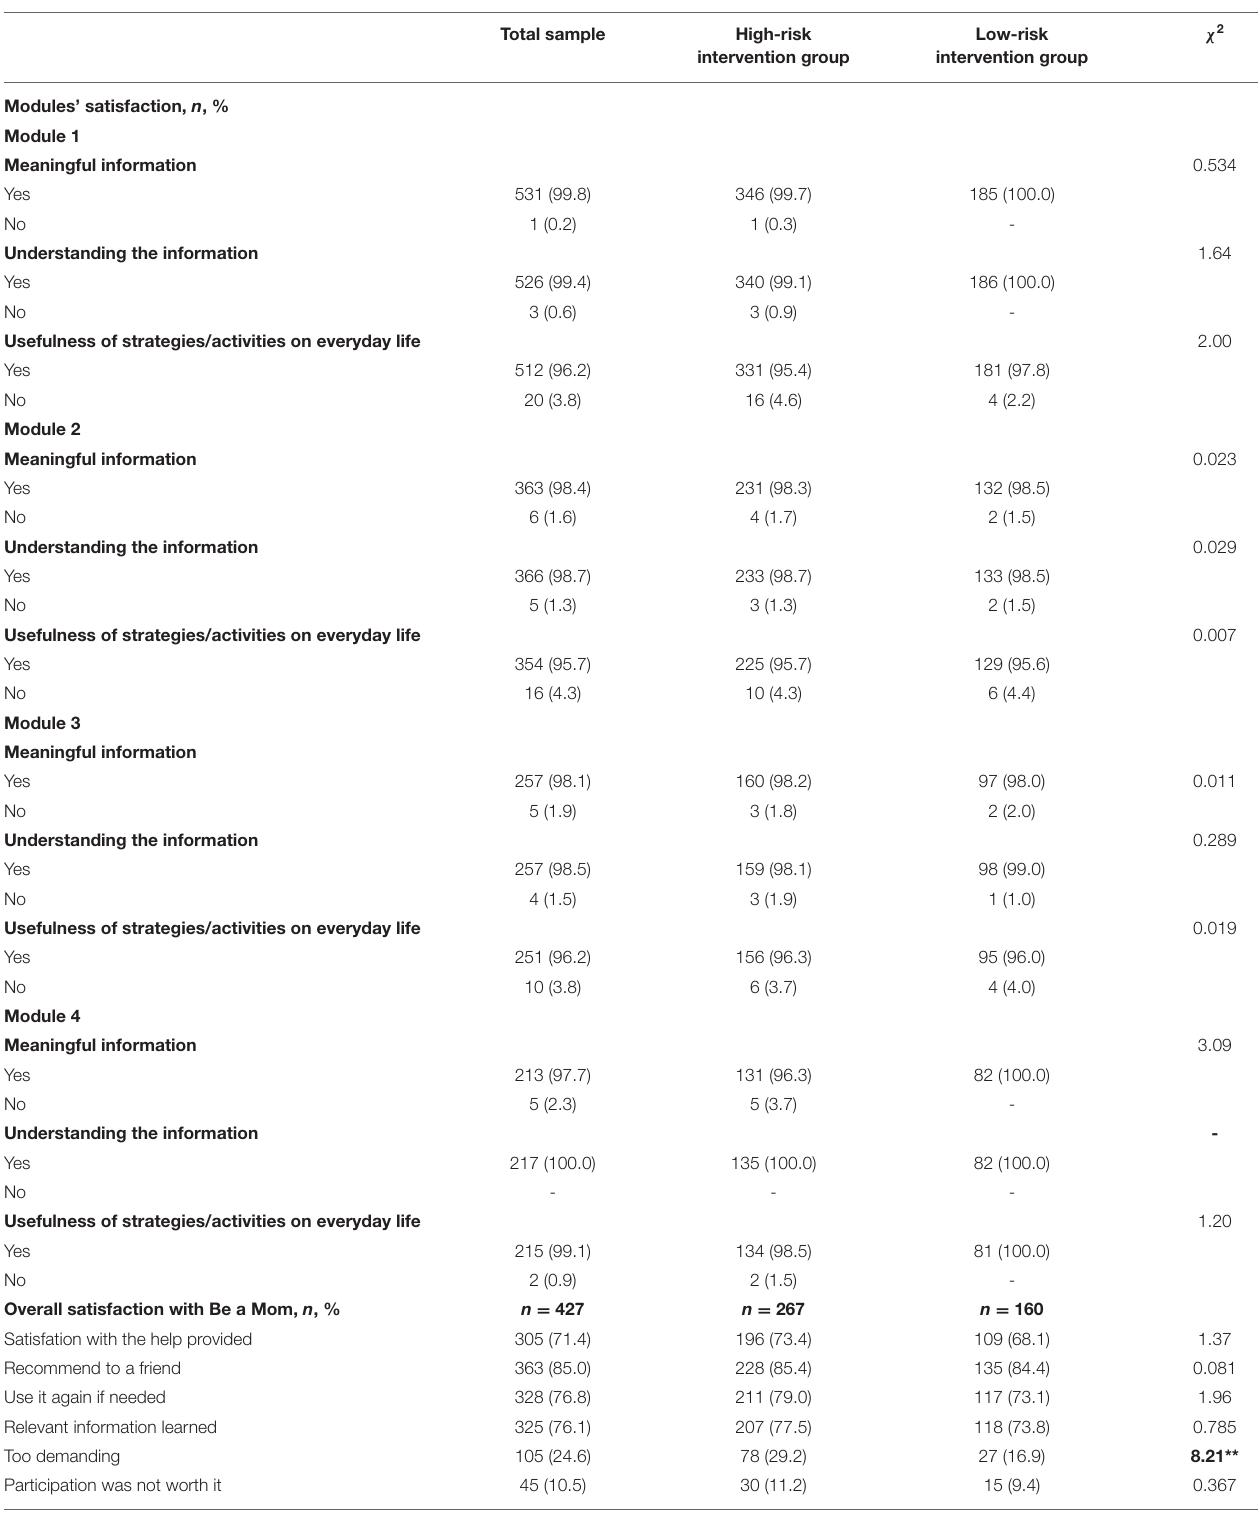
TABLE 4 | Be a Mom’s